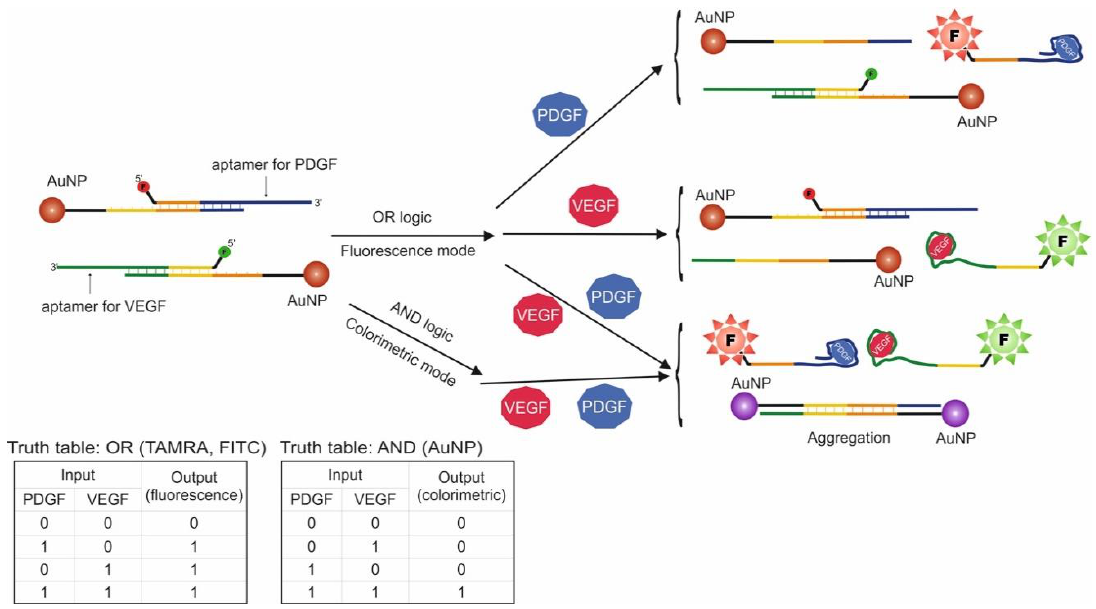
Figure 4. OR and AND logic gates. PDGF = platelet-derived growth factor, VEGF = vascular endothelial growth factor, F—fluorescent label. Adapted from Reference [38]. Copyright © 2020, American Chemical Society.